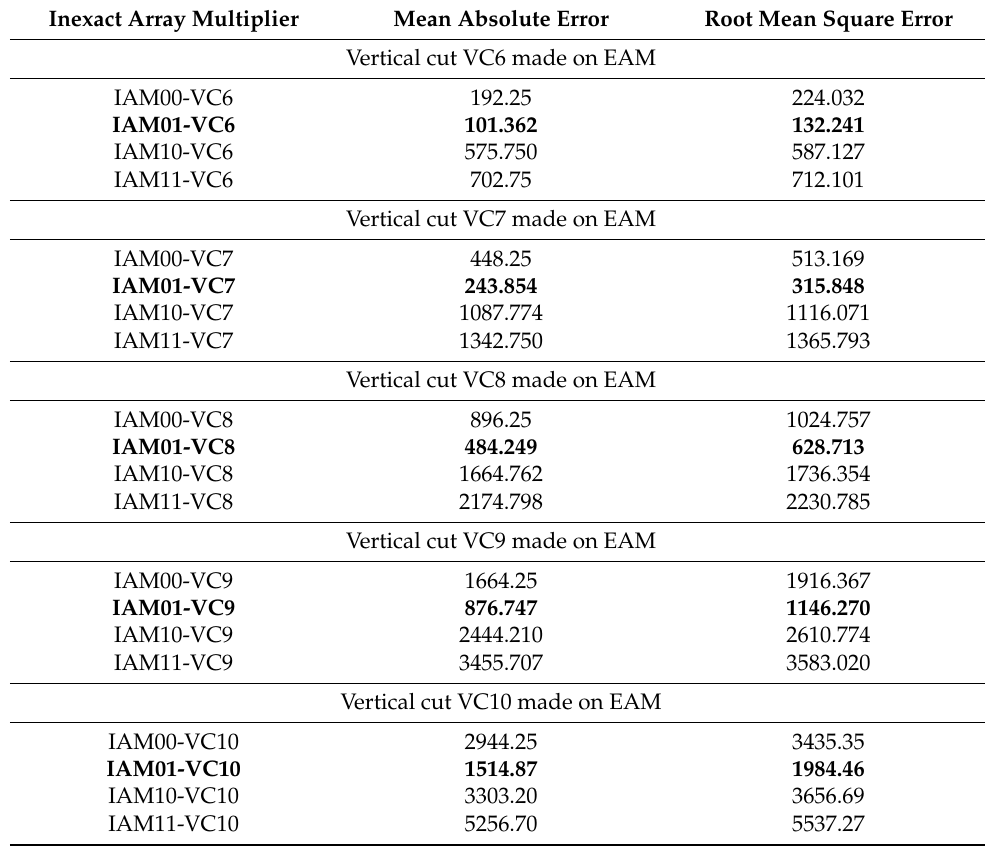
Table 1. Error metrics of various inexact array multipliers, obtained by making vertical cuts VC6 to VC10 on the exact array